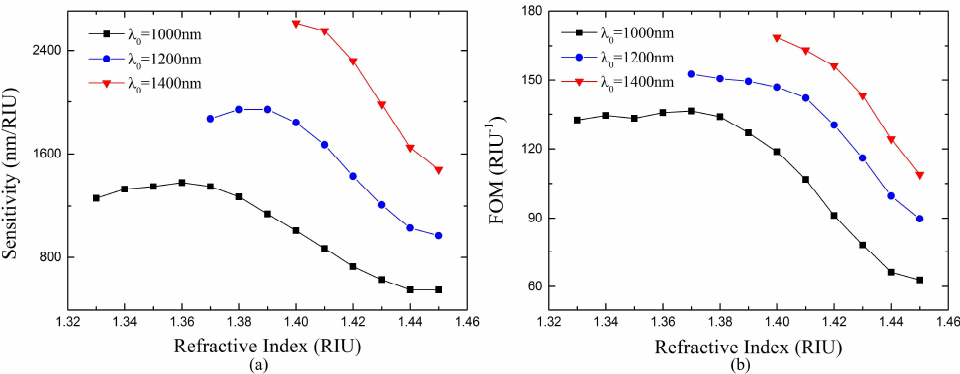
Figure 11. Theoretical results of performance of the proposed sensor with different center wavelength. ( a ) Sensitivity versus n s ; ( b ) FOM versus n s .